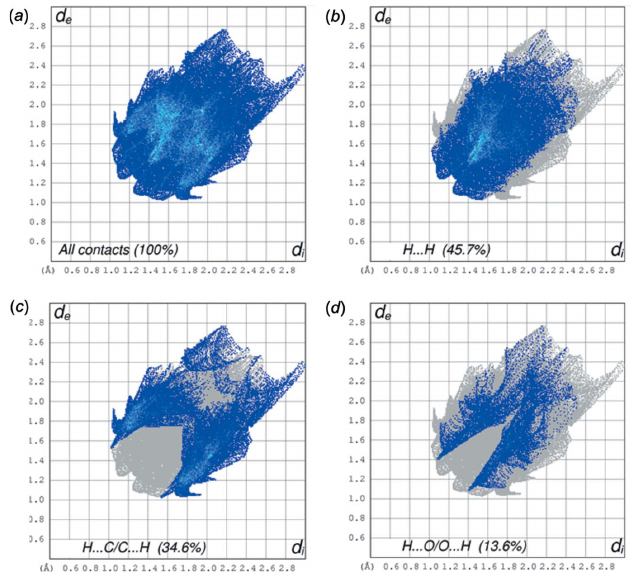
Figure 4 The two-dimensional fingerprint plots of (I): ( a ) all interactions; ( b ) H (cid:2)(cid:2)(cid:2) H; ( c ) H (cid:2)(cid:2)(cid:2) C/C (cid:2)(cid:2)(cid:2) H; ( d ) H (cid:2)(cid:2)(cid:2) O/O (cid:2)(cid:2)(cid:2)